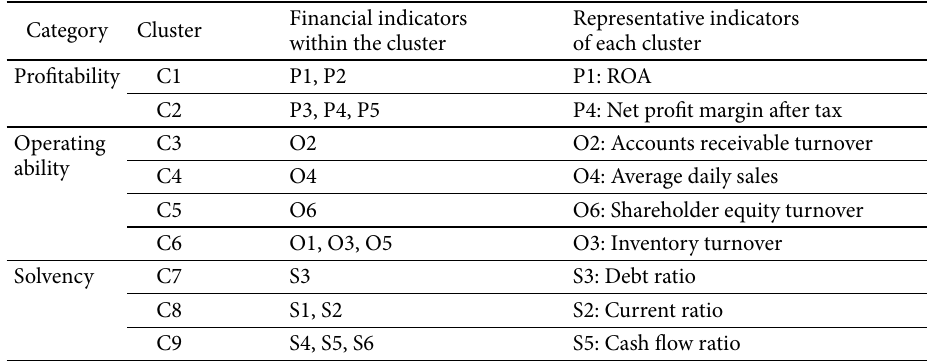
Table 7. The classification of financial indicators and select the representative indicators Financial indicators Category Cluster within the cluster